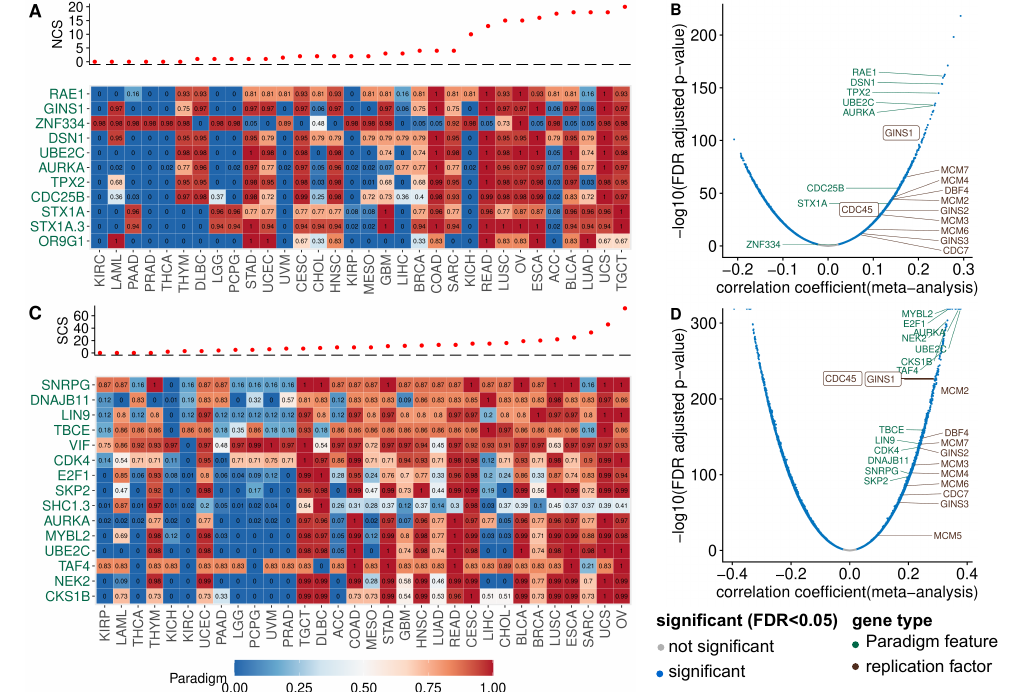
Figure 3. PARADIGM pathway activity and gene expression associated with CIN. ( A ) The PARADIGM pathway-level activities corresponding to protein-coding genes (rows) were correlated with the NCS. Only pathways with a significant correlation (FDR-adjusted p < 5%) larger than 0.3 in at least seven cancer types were included. The heatmap shows the normalised PARADIGM pathway activity (0–1 from low to high). Cancer types were ordered according to their median NCS, see top panel. ( B ) Volcano plot for the correlation between gene expression and NCS. ( C ) Analogous to ( A ), but for the SCS instead of the NCS. ( D ) Correlation of SCS and gene expression, analogous to ( B